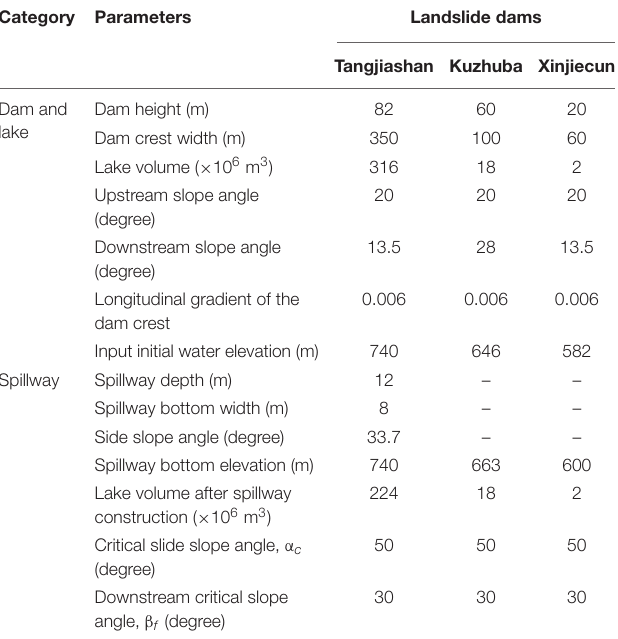
TABLE 1 | Parameters of the three landslide dams (based on Shi et al.,